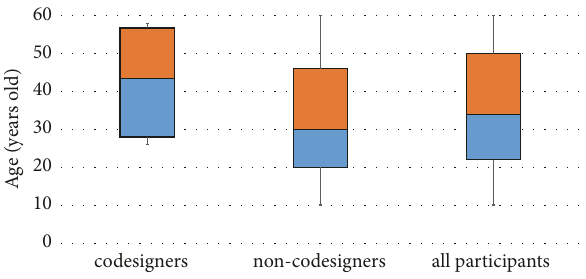
Figure 12: Age distribution among the